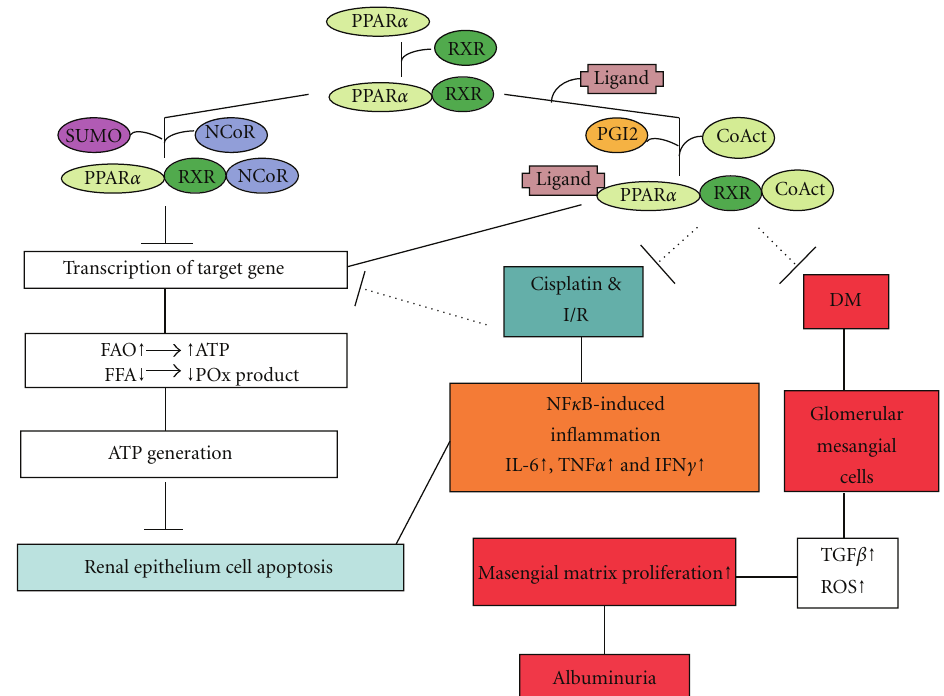
Figure 1: Schematic diagram presenting the signaling pathways of PPAR α involved in the mechanisms of ischemic/reperfusion-, drugs-, or diabetic-induced renal damage. PPAR α forms heterodimer with RXR. In the absence of ligands, the dimer may recruit a corepressor, inhibiting PPAR α -mediated transcription of target genes. The presence of an agonist, or an activator such as PGI2, triggers the recruitment of a coactivator complex which induces transcriptional activity of PPAR α onto its target genes. This leads to an increase in fatty acid catabolism and adenosine triphosphate (ATP) production, also to decrease the levels of cytotoxic fatty acid peroxidation (PO x ) products, and, consequently, to promote cell viability and inhibit renal epithelium cell death. In addition, PPAR α complex can attenuate NF κ B- induced inflammatory factors (IL-6, INF γ , or TNF α ) induced by ischemic/reperfusion injury (I/R) or drugs. Furthermore, PPAR α complex can inhibit masengial matrix proliferation induced by TGF β or reactive oxidative stress (ROS) which then resulted in albuminuria. After SUMOylation of PPAR α , SUMOylated PPAR α resulted in downregulation of its transcriptional activity by promoting its interaction with the corepressor NCoR, which will compromise cell viability and activate cell death processes. CoAct, coactivator; DM, diabetes mellitus; FAO, fatty acid oxidation; FFA, free fatty acid; IFN γ , interferon γ ; IL-6, interleukine-6; I/R, ischemia/reperfusion; NCoR, nuclear corepressor; NF- κ B, nuclear factor- κ B; PGI2, prostacyclin; POx, peroxidation; PPAR α , peroxisome proliferator-activated receptor- α ; RXR, retinoid